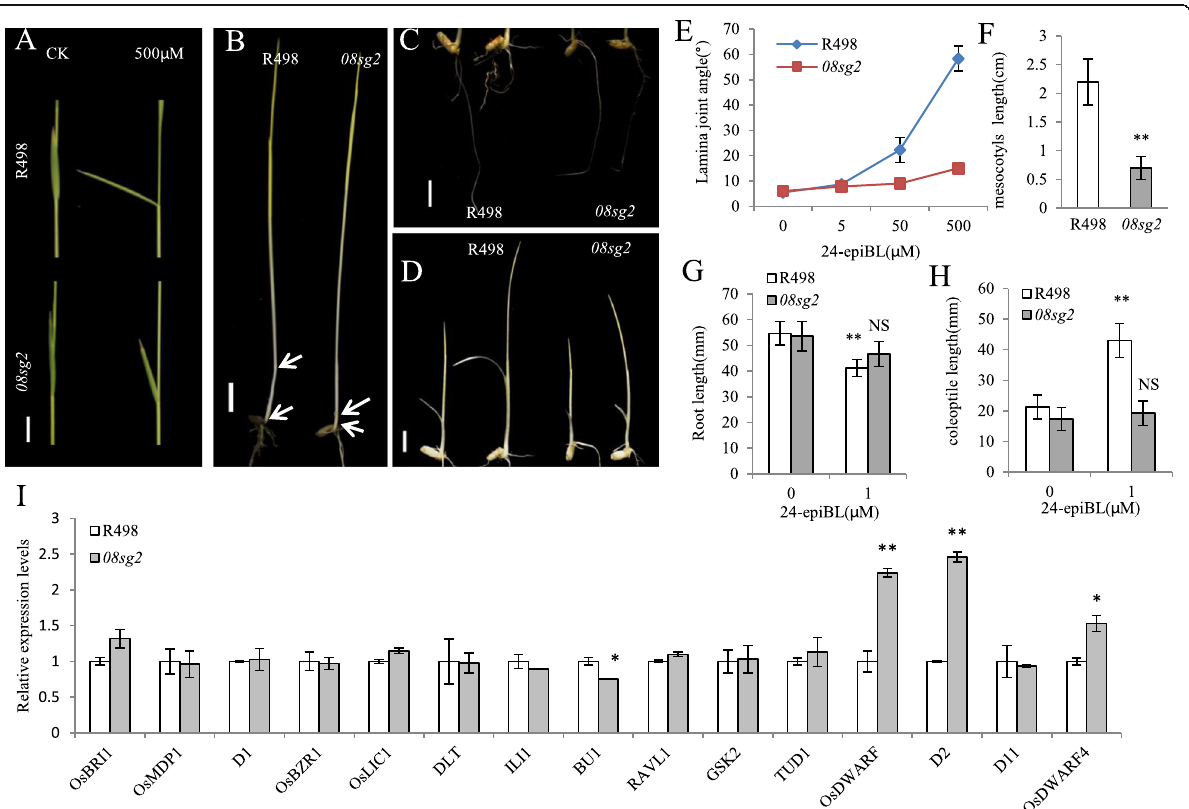
Fig. 4 The 08sg2 mutant is insensitive to 24-epiBL. a Lamina joint of R498 and 08sg2 in response to 24-epiBL treatment. b Comparisons of the mesocotyls elongation between R498 and 08sg2 when plants were grown in complete darkness, arrows indicate the nodes. c Roots of R498 and 08sg2 seedlings grown on ½MS medium without (left) or with (right) 1 μ M 24-epiBL treatment. d The coleoptile elongation of R498 and 08sg2 without (left) or with (right) 1 μ M 24-epiBL treatment. e Measurements of the lamina joints angles of the wild type and 08sg2 after treatment with various concentrations of 24-epiBL. f The mesocotyls length of R498 and 08sg2 when plants were grown in complete darkness. g Roots length of R498 and 08sg2 seedlings grown on ½MS medium with 1 μ M 24-epiBL treatment. h Coleoptile length of R498 and 08sg2 seedlings grown on ½MS medium with 1 μ M 24-epiBL treatment. Bars = 10 mm. i The analysis of relative expression level was determined by qRT-PCR using young panicles (5-7 cm) during the inflorescence development. OsActin was used as the control and the values of expression levels in R498 were set to one ( n = 3). Data are given as means ± SD. Student ’ s t-test was used to generate the P values; *, ** and NS indicate P < 0.05, P < 0.01 and